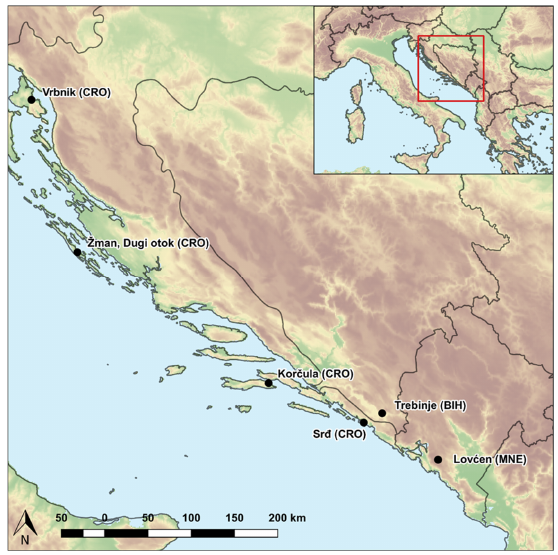
Figure 1. Sampling locations of the six natural Dalmatian pyrethrum populations.